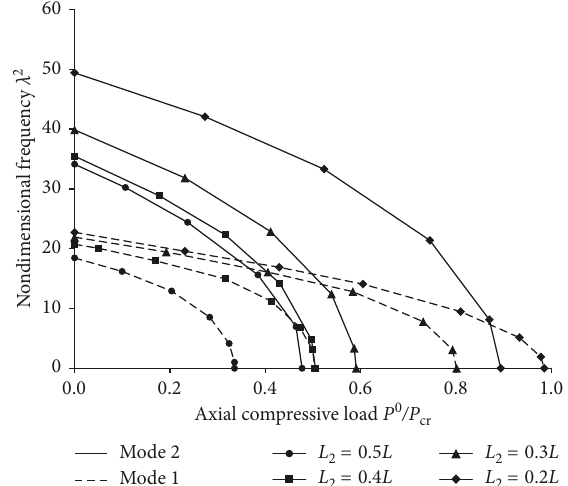
Figure 6: Changes of the nondimensional first and second natural frequencies ( λ 2 ) with respect to normalized buckling load P 0 / P cr for H 2 / H 0.3, M zz / M b 0.4, and different values of L 2 / L (cid:31) (cid:31)